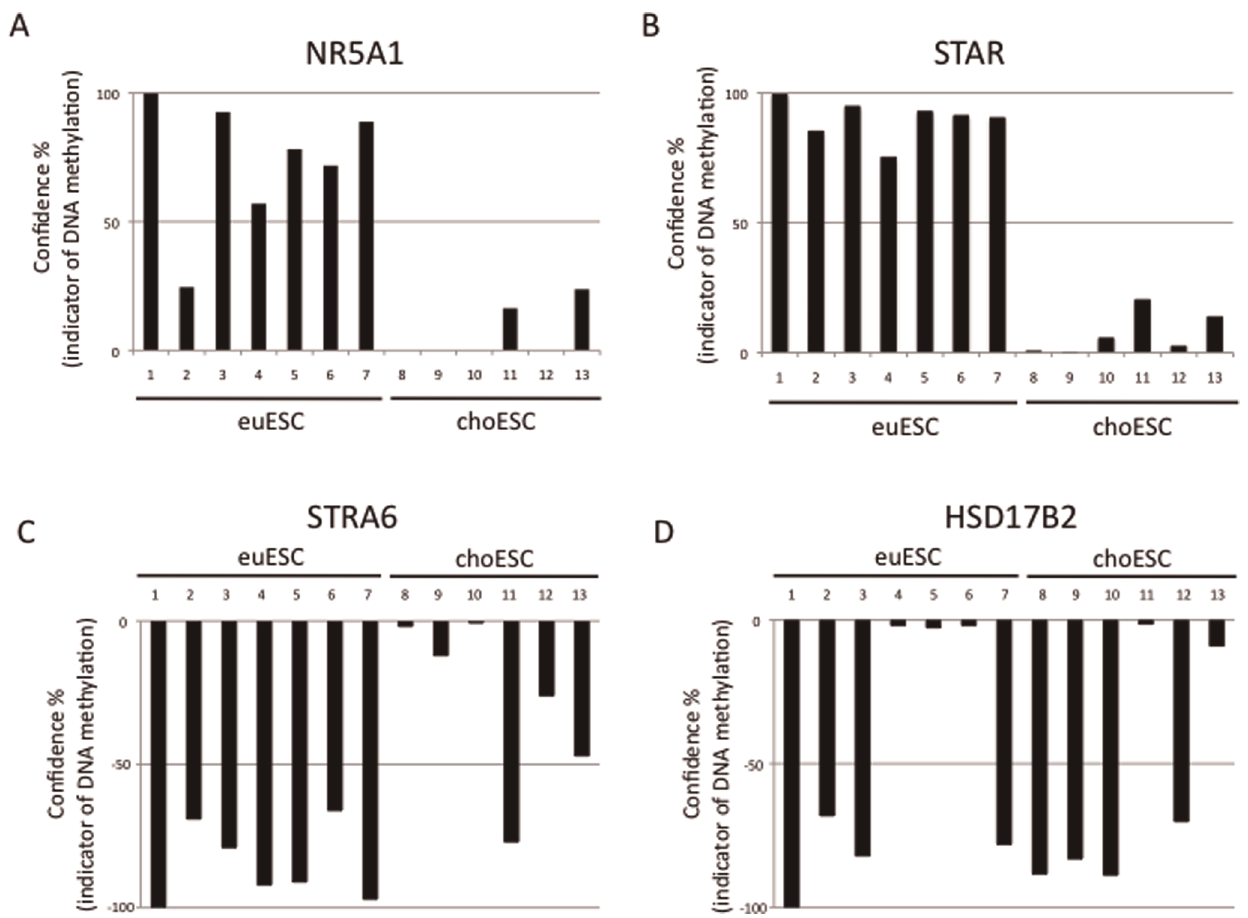
Figure 5. The DNA methylation status as determined by the methylation-sensitive high resolution analyses (MS-HRMA) of NR5A1 (A), STAR (B), STRA6 (C) and HSD17B2 (D) in euESCa and choESC. Sample No. 1, 6, 7 were analyzed for genome-wide DNA methylation and transpciptome as euESCa, and sample No. 8, 9, 10 were also analyzed as choESC. Sample No. 1 and 10 were analyzed for bisulfite sequencing as euESCa and choESC, respectively. The confidence value calculated by MS-HRMA indirectly indicates the DNA methylation level. The DNA methylation status of euESCa-1 was shown as 100% identical with regard to the DNA methylation. The confidence values of each sample were calculated in comparison with euESCa-1. In NR5A1 and STAR, the confidence values were lower in choESC than those in euESCa, indicating that the choESC are hypomethylated compared with the euESCa. In STRA6 and HSD17B2, the DNA methylation status of euESCa-1 was shown as 2 100% (arbitrary defined reverse axis value) identical regarding DNA methylation, indicating a DNA hypomethylation status. In STRA6, the confidence values were higher in choESC than those in euESCa, indicating that the choESC are hypermethylated compared with the euESCa. In HSD17B2, the DNA methylation status varied among individuals with euESCa and choESC. The samples of euESCa and choESC were isolated from seven and six patients, respectively.